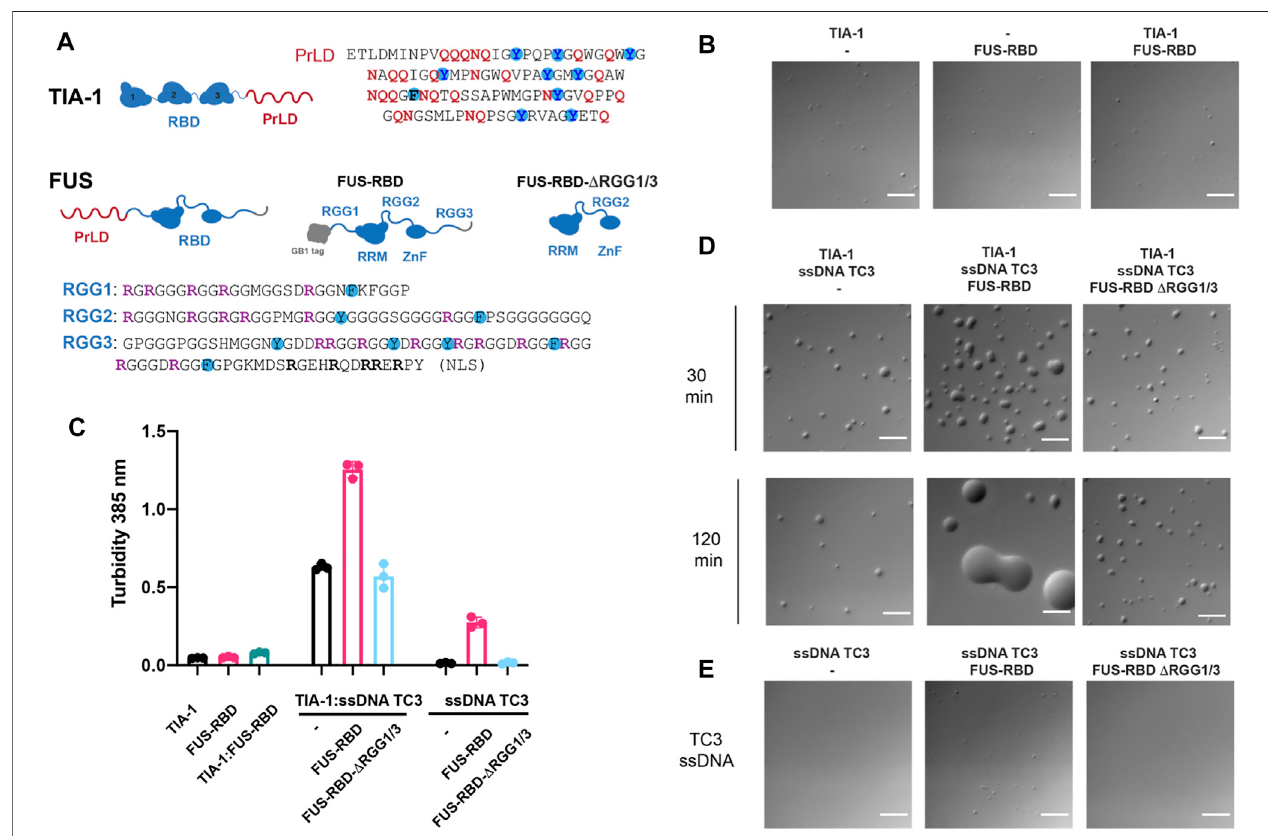
FIGURE4| FUS-RBD enhancesnucleicacidinducedLLPS ofTIA-1. (A) Domainstructures ofTIA-1(with PrLDsequencealongsidehighlightingQ,NandY amino acids) and FUS constructs: FUS-RBD and FUS-RBD- Δ RGG1/3 constructs (with RGG sequences shown underneath highlighting R, F and Y amino acids). (B) DIC microscopy of 2.5 μ M TIA-1; 0.5 μ M ssDNA TC3; 2.5 μ M FUS-RBD-RGG; 2.5 μ M FUS-RBD-short at room temperature (C) Turbidity assay of 2.5 μ M TIA-1; 0.5 μ M ssDNA TC3; 2.5 μ M FUS-RBD-RGG; 2.5 μ M FUS-RBD-short. 20 min incubation at 25 ° C. 3 replicates. Error bars represent S.D. (D) DIC microscopy of 2.5 μ M TIA-1combinedwith0.5 μ MssDNATC3aloneorwith2.5 μ MFUS-RBD-RGGor2.5 μ MFUS-RBD-shortat30and120 minincubationatroomtemperature. (E) 0.5 μ M ssDNA TC3 alone or with 2.5 μ M FUS-RBD-RGG or 2.5 μ M FUS-RBD-short. Scale bars depict 10 μ m. Conditions: 20 mM HEPES, 50 mM NaCl, 12 mM arginine, pH 7.2, at 25 °